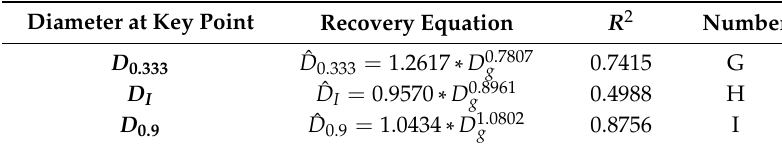
Table 7. Recovery equations and their prediction e ff